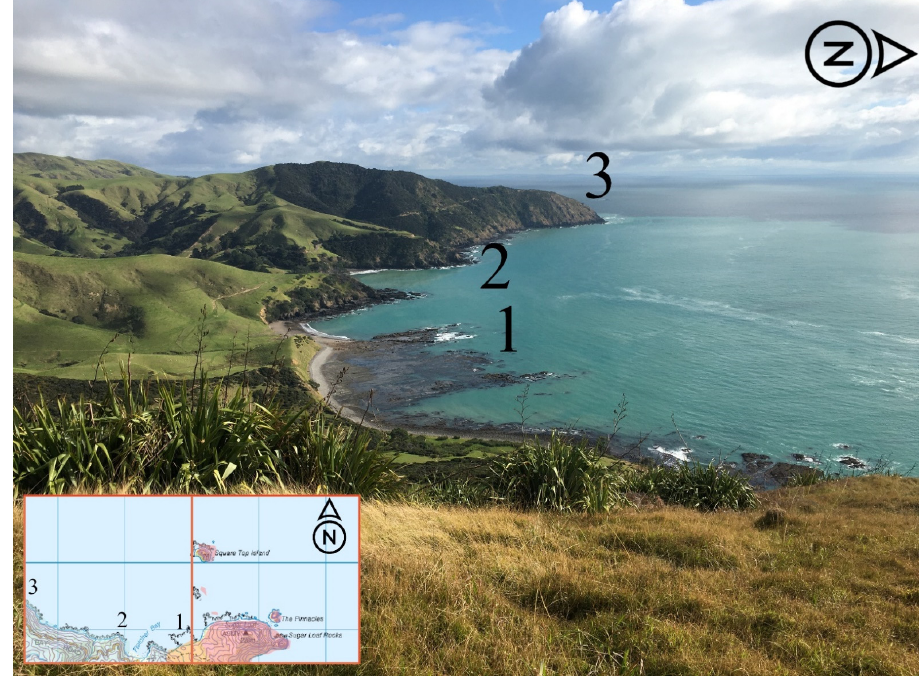
Figure 9. Landscape of zone number 3 Fletcher Bay district (Coromandel Peninsula). This zone has a middle value of Geodiversity. Geology represented by Late Jurassic Greywacke, and Quaternary Sediments, while geomorphology is diverse with a distinctive number of green rolling hills. This picture is presented to visualize the scale of research (6.25 km 2 for each zone, 2.5 km the length of side of grid) and full territory of zone 3. Numbers show the places on the picture and topographic map of zones 3 and 4 (bottom left). Land 2021 , 10 , x FOR PEER REVIEW